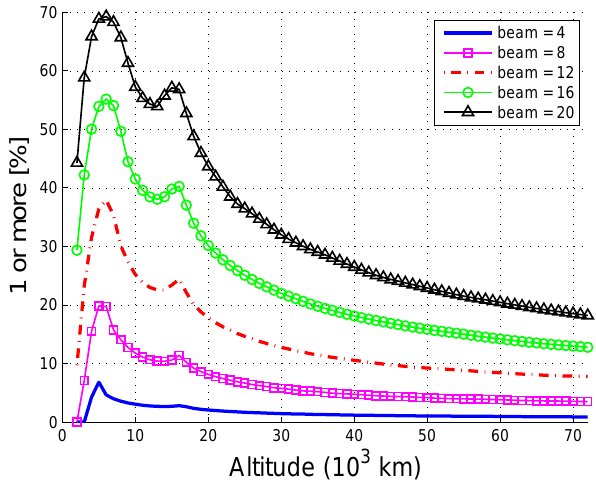
Figure 14. Availability as a function of beamwidth